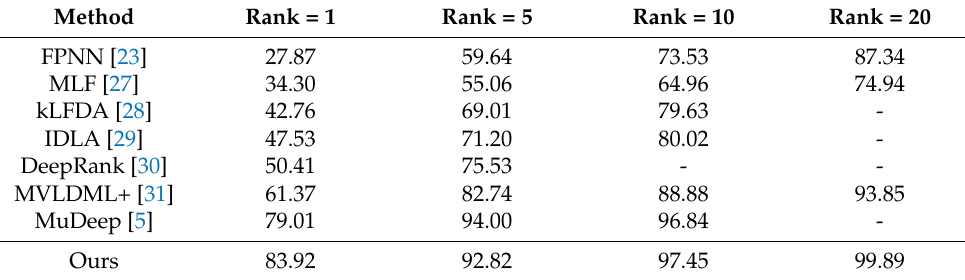
Table 1. Experimental results on CUHK-01.